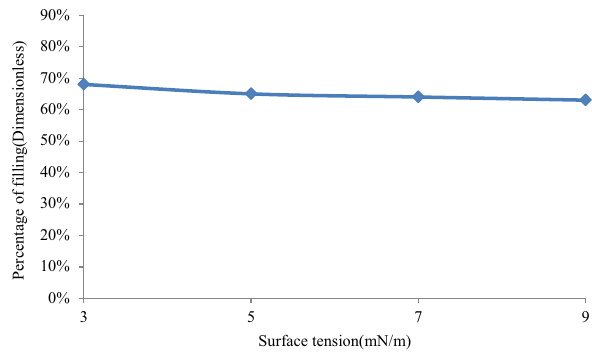
Fig. 10 Filling ratios at different surface